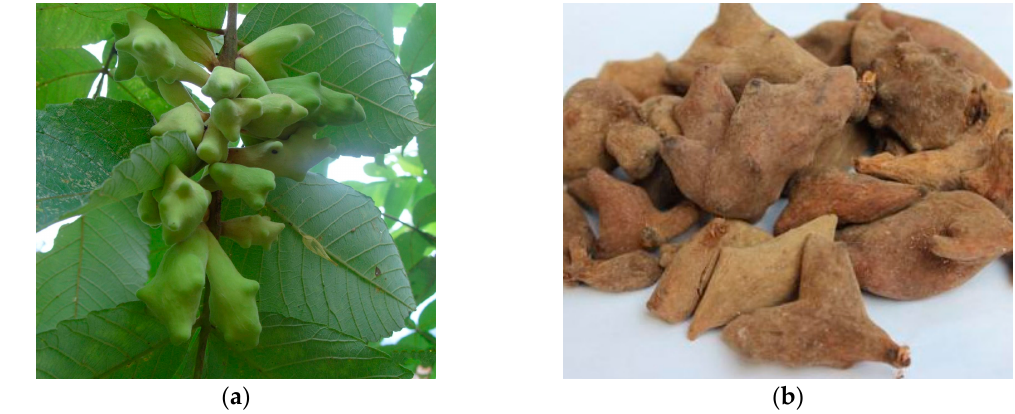
Figure 1. Chinese Du-ensiform gallnut, ( a ) fresh gallnut; ( b ) dry gallnut.